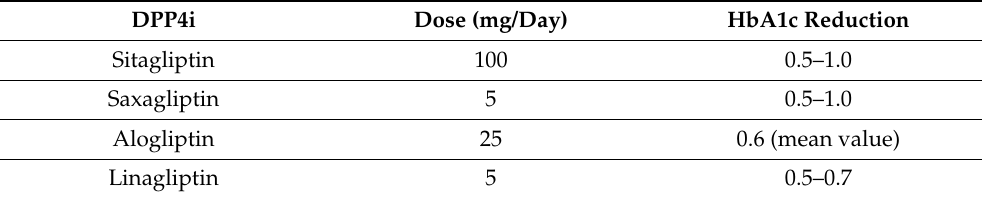
Table 3. The effect of DPP4 inhibitors in HbA1c. DPP4i Dose